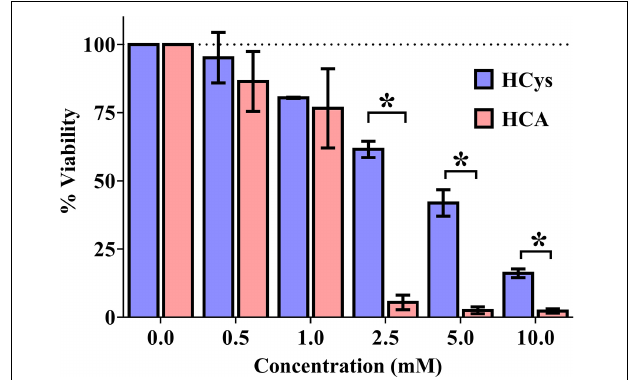
FIGURE 2 | Luciferase-based cell viability measurement of primary cortical neurons (10,000 per well) after 24 h of incubation with homocysteine (HCys) or homocysteic acid (HCA); mean ± SEM ( n = 3); p < 0.05 ( t -test) considered statistically significant